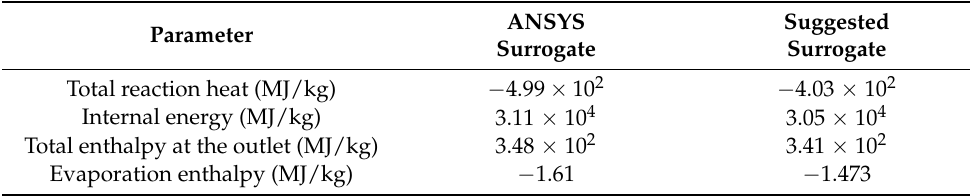
Table 3. Thermodynamic characteristics of the combustion